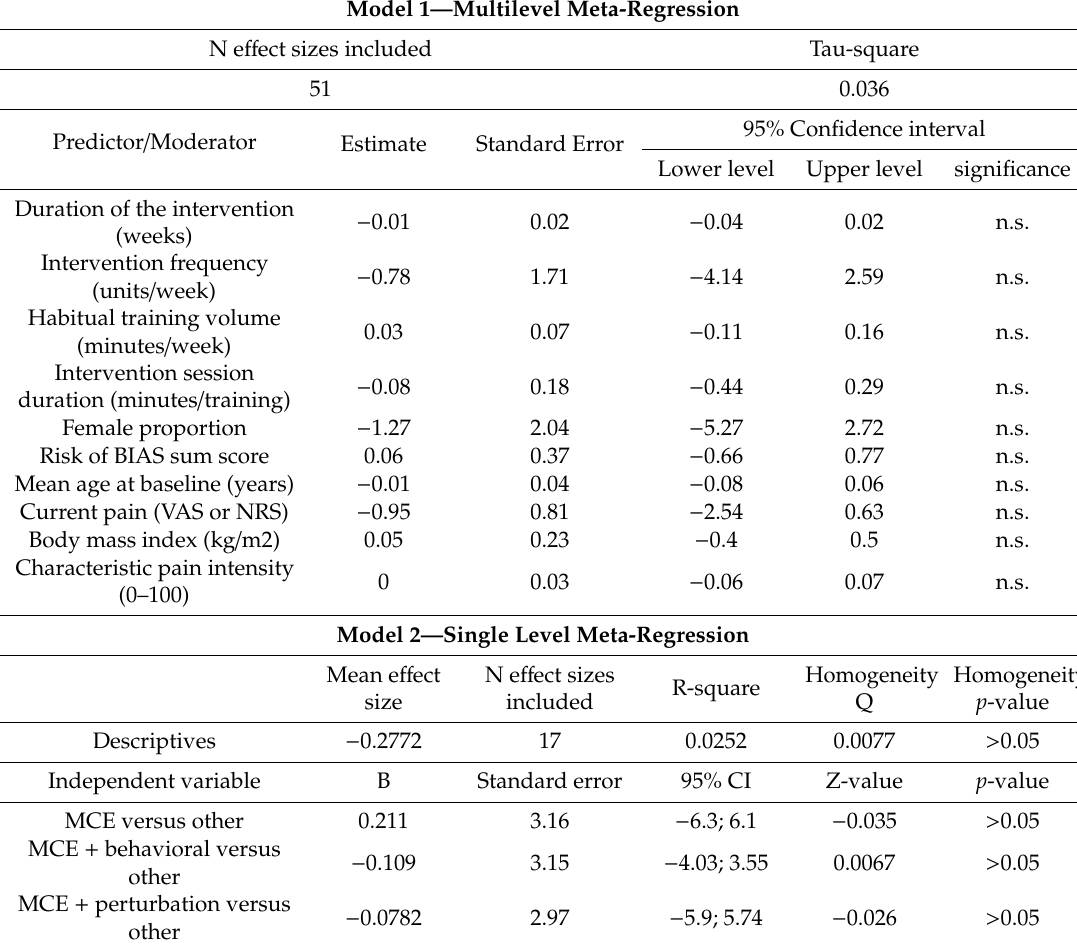
Table 3. Sensitivity meta-regression analyses outcomes, dependent variable = standardized mean di ff erences (Hedges d) of the subjective disability score. Model 1-multilevel meta-regression; Model 2-single level meta-regression on intervention type. Each time, the total e ff ect model descriptives and the contribution of the single predictors (independent variables) are